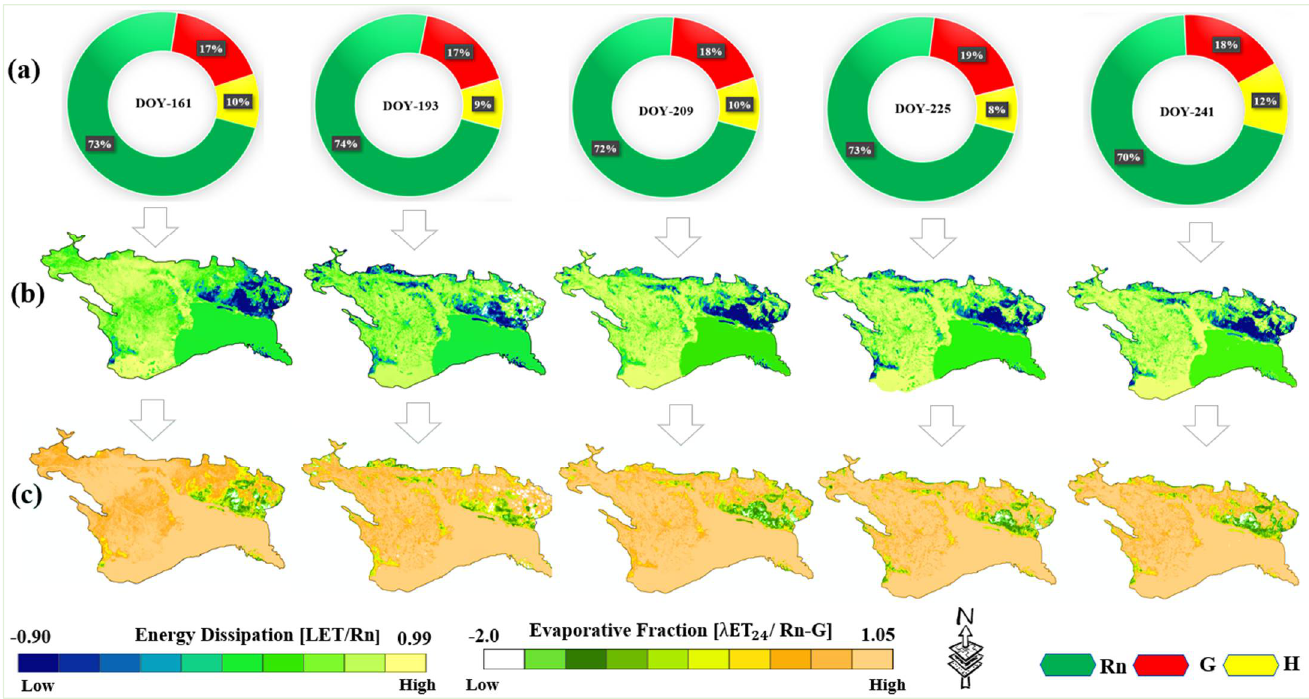
Figure 8. Near-surface energy components proportion over Yanqi basin where: ( a ) The partition of main near-surface energies for LE of evapotranspiration during summertime (Rn, G, and H); ( b ) Dissipation of net radiation amongst latent heat flux of evapotranspiration (LE/Rn) during the understudied period (DOY), ( c ) Evaporative fraction displaying the ratio between the latent heat flux and the available energy.